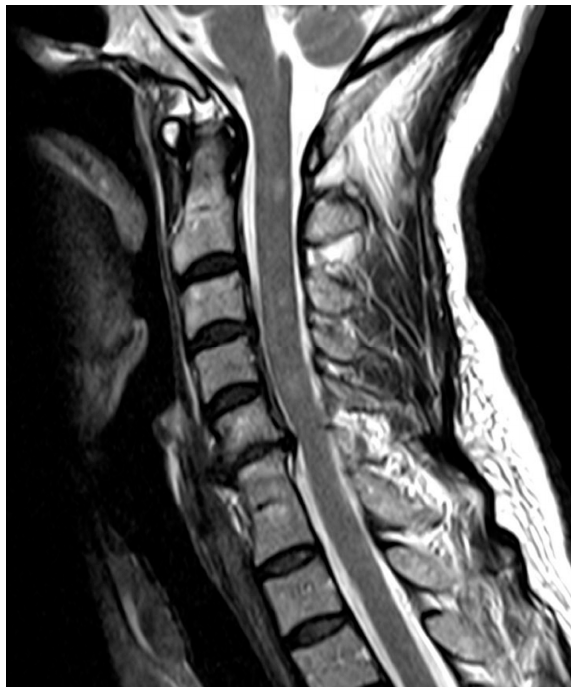
Figure 2. Sagittal T2-weighted fast spin-echo sequence; 53 y/o female; congenital block vertebra C6/7 with degenerative changes in segment C5/6 (disk prolapse) and otherwise normal cervical spine consistent with ASDI. Please also note T2-hyperintense lesions in the cervical spinal cord consistent with demyelination in this multiple sclerosis patient.